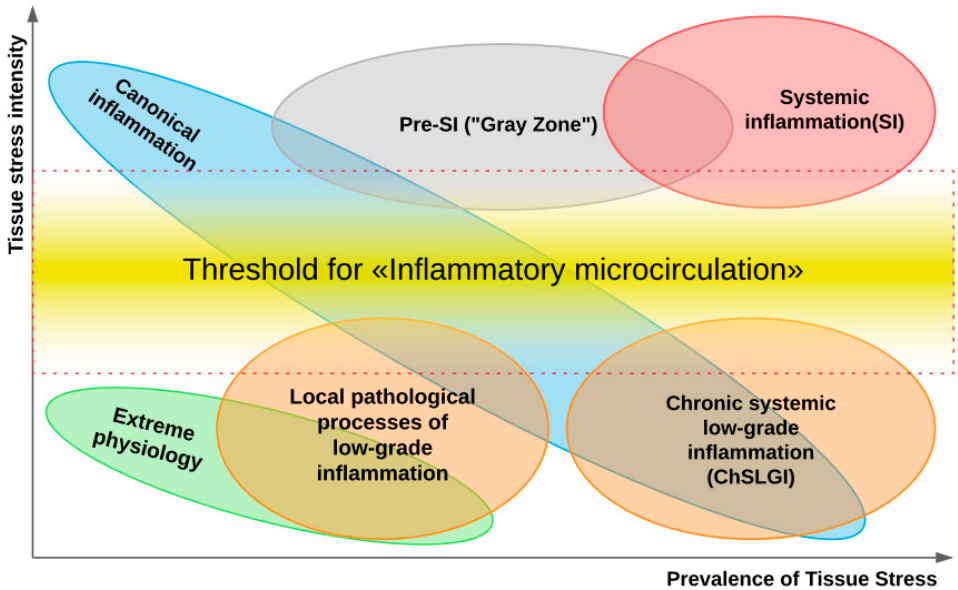
Figure 1. Tissue stress and general pathological processes (from Gusev E. et al., 2021). Note: The ratio of intensity to prevalence of damaging factors initiating a “response” in the form of